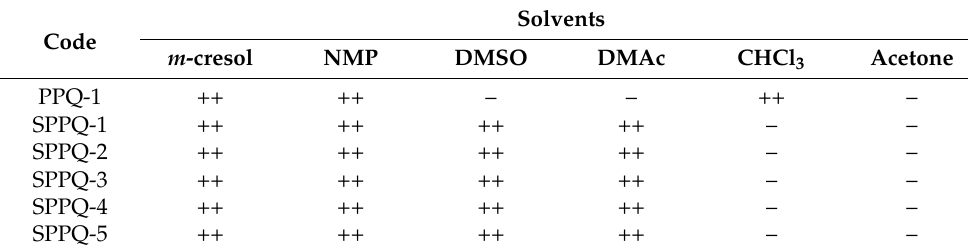
Table 2. Solubility behaviors of SPPQs